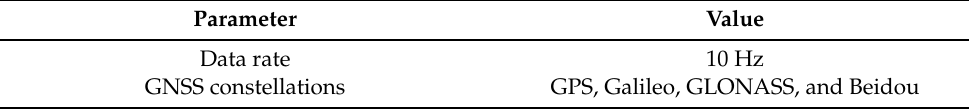
Table 2. GNSS sensor